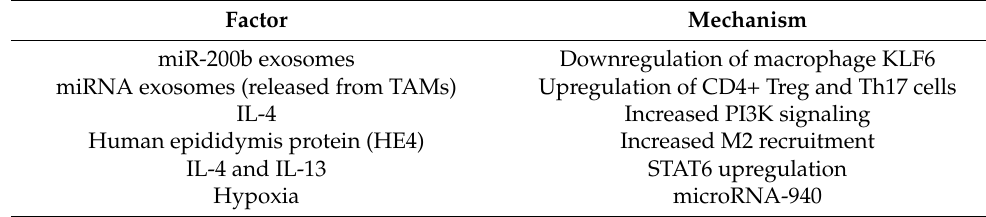
Table 1. Factors influencing M2